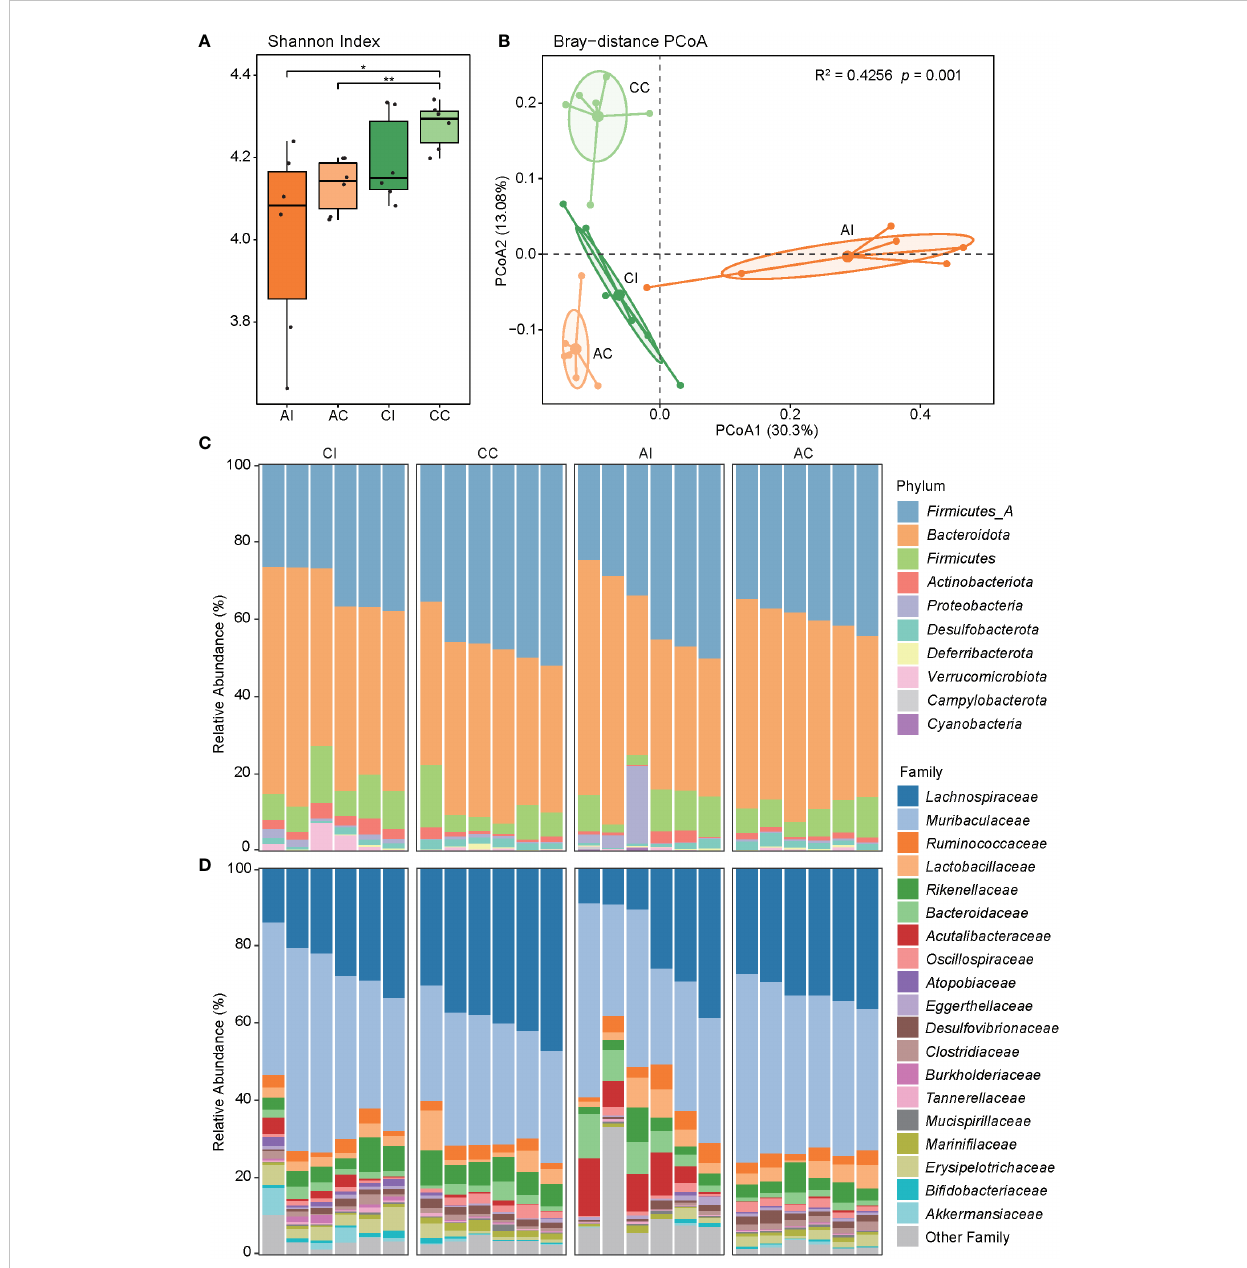
FIGURE 2 The diversity and composition of the microbial community. (A) The Shannon index of the mouse gut microbiota in each group, and asterisks indicate a statistical signi fi cance: * indicates p < 0.05; ** indicates p < 0.01. (B) PCoA shows the beta diversity of the microbial community. Community differences are veri fi ed by PERMANOVA. (C, D) The bar chart shows the taxonomic composition at the phylum and family